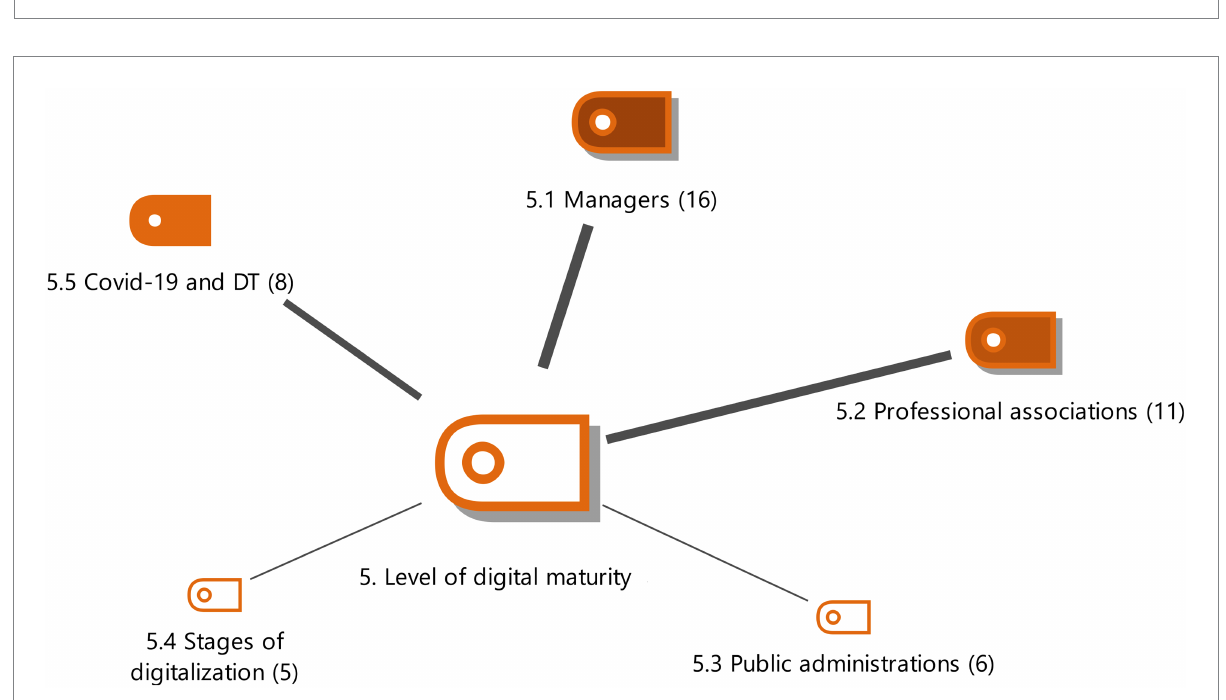
FIGURE 6 Level of Digital Maturity with the weightings of the properties. Source: Authors own.